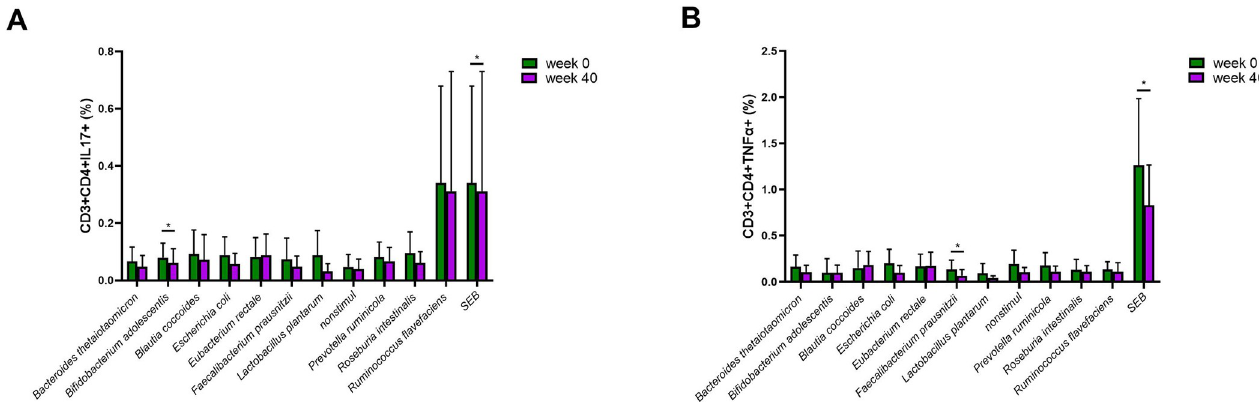
Fig 6. Production of IL-17 and TNF- α by circulating microbiota-reactive T cells of patients with IBD on ustekinumab therapy at baseline (week 0) and at week 40. IL-17 A) and TNF- α B) production by CD3+CD4+ T cells isolated from patients PBMC after stimulation with assorted bacterial lysates, as determined by a paired t-test. � p < 0.05, IBD (n = 8), SEB (Staphylococcal enterotoxin